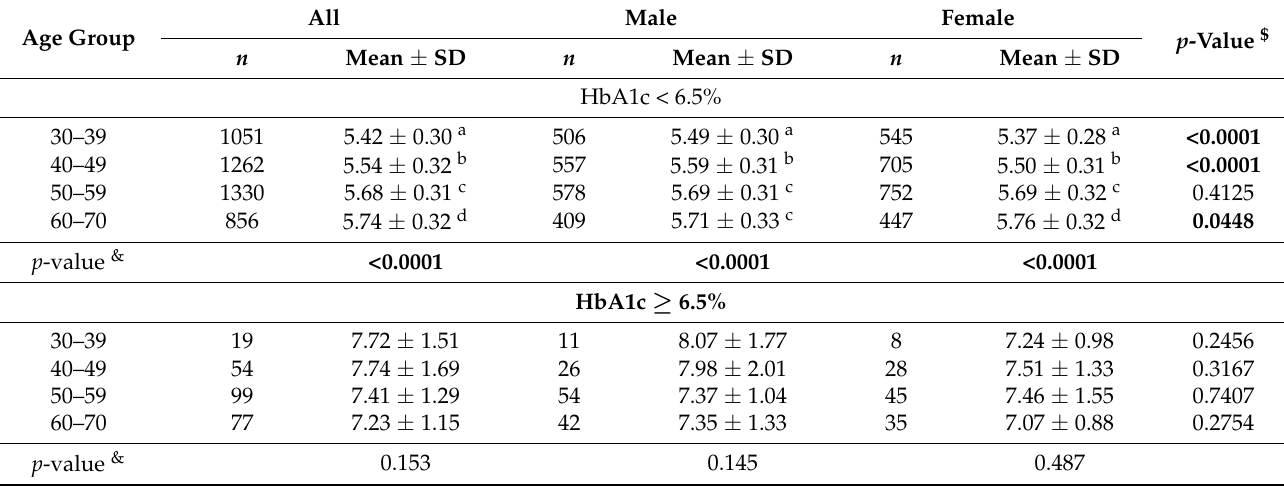
Table 6. HbA1c levels of different age groups between sexes for HbA1c < 6.5% and HbA1c ≥